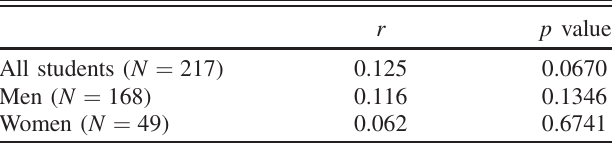
TABLE III. Correlation of the normalized FCI gain and pretest FCI scores, including the regression coefficient r and the p value, for all students, men, and women.